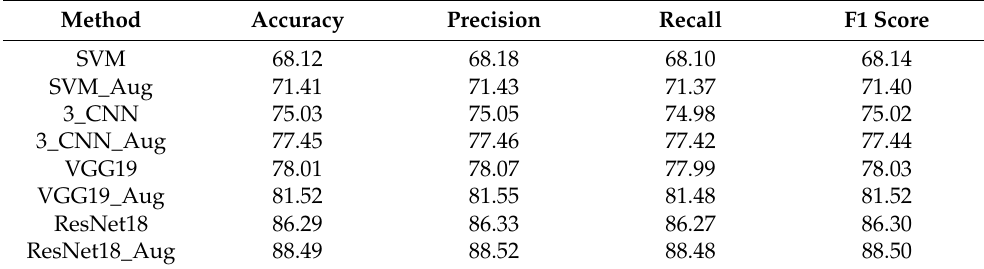
Table 5. Accuracy comparison (%) for the LOFAR spectrum by different methods.